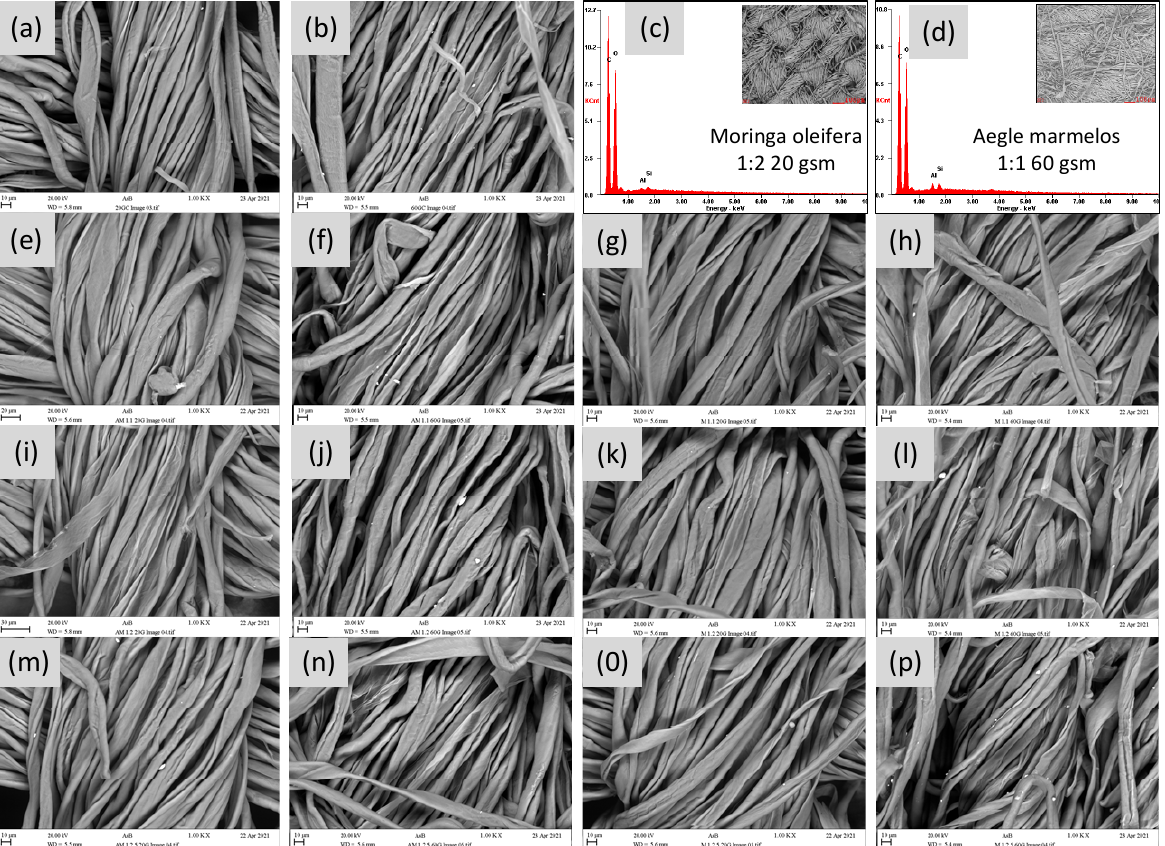
Figure 12. SEM of treated fabrics (padding method): ( a ) 20 gsm control fabric; ( b ) 60 gsm control fabric; ( c ) EDX analysis 1:2 nano-emulsion (Moringa oleifera) 20 gsm fabric; ( d ) EDX analysis 1:1 nano-emulsion 1 (Aegle marmelos) 60 gsm fabric; ( e ) 20 gsm treated with nano-emulsion 2, 1:1 ratio; ( f ) 60 gsm treated with nano-emulsion 2, 1:1 ratio; ( g ) 20 gsm treated with nano-emulsion 1, 1:1 ratio; ( h ) 60 gsm treated with nano-emulsion 1, 1:1 ratio; ( i ) 20 gsm treated with nano-emulsion 2, 1:2 ratio; ( j ) 60 gsm treated with nano-emulsion 2, 1:2 ratio; ( k ) 20 gsm treated with nano-emulsion 2, 1:2 ratio; ( l ) 60 gsm treated with nano-emulsion 1, 1:2 ratio; ( m ) 20 gsm treated with nano-emulsion 2, 1:2.5 ratio; ( n ) 60 gsm treated with nano-emulsion 2, 1:2.5 ratio; ( o ) 20 gsm treated with nano-emulsion 1, 1:2.5 ratio and ( p ) 60 gsm treated with nano-emulsion 1, 1:2.5 ratio.